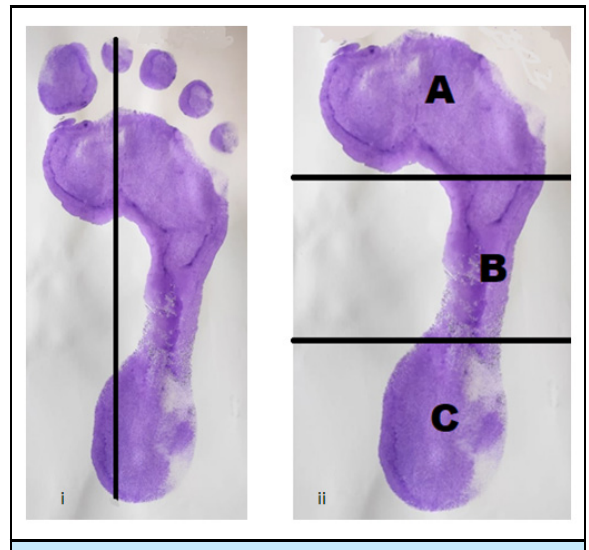
Figure 1. (i) Showing foot print of right foot with its central axis passing from the heel to the 2nd toe. (ii) Showing the area of Fore foot (A), Mid foot (B) and Heel region (C) of the foot.